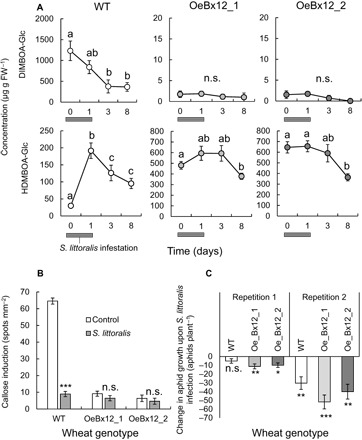
DIMBOA-Glc O-methylation mediates a trade-off between induced caterpillar and aphid resistance.(A) Changes in major benzoxazinoids in WT and ZmBx12-overexpressing lines at different time points following 24 hours of S. littoralis attack (n = 5 to 7). Different letters indicate significant differences in concentrations over time (ANOVA followed by Holm-Sidak post hoc tests, P < 0.05). (B) Callose inducibility in control and S. littoralis–attacked wheat plants (n = 12 to 20). Asterisks indicate significant differences between treatments (two-way ANOVA followed by Holm-Sidak post hoc tests, *P < 0.05, **P < 0.01, ***P < 0.001). (C) Aphid performance on S. littoralis–attacked wheat plants relative to nonattacked controls (n = 9 to 11). Results from two repetitions of the experiments are shown side by side. Stars indicate a significant reduction of aphid growth induced by S. littoralis caterpillar feeding relative to S. littoralis–unattacked plants (two-way ANOVA followed by Holm-Sidak post hoc tests.